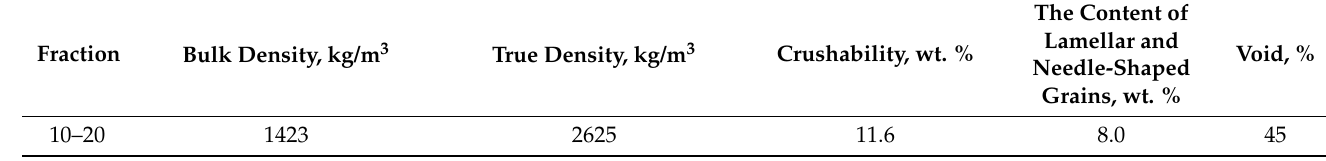
Table 6. Physical and mechanical characteristics of crushed granite.